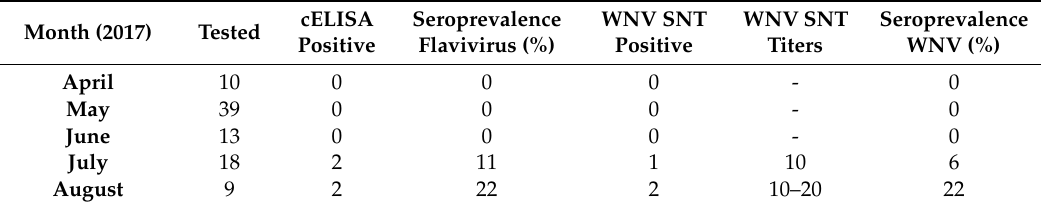
Table 1. Results of the cross-sectional serosurveys carried out in magpies in 2017 for the detection of West Nile virus (WNV) infection.